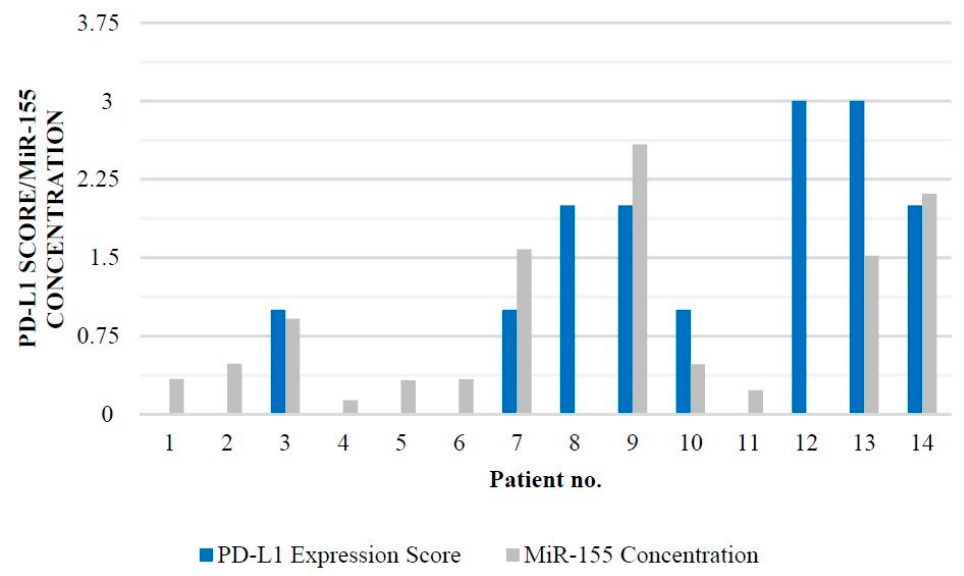
Figure 2. Molecular status of PD-L1 expression score and miR-155 concentration in several patients with p-HGG